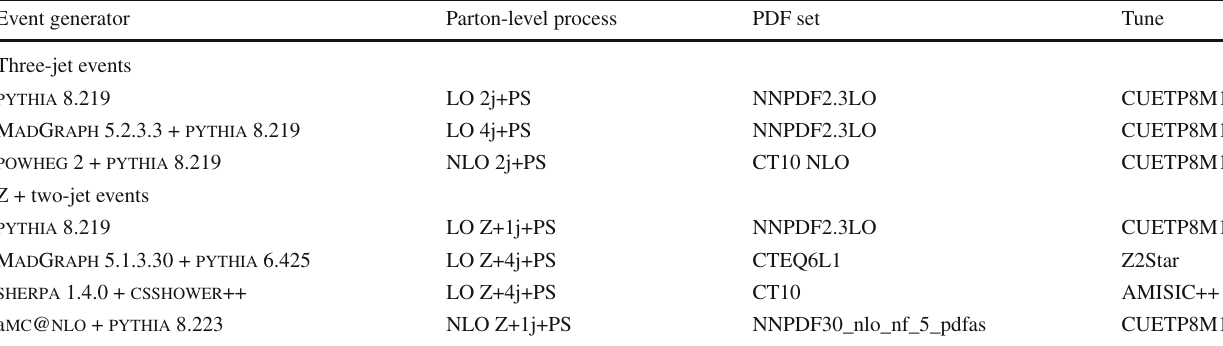
Table 3 MC event generators and version numbers, parton-level processes, PDF sets, and UE tunes used for the comparison with